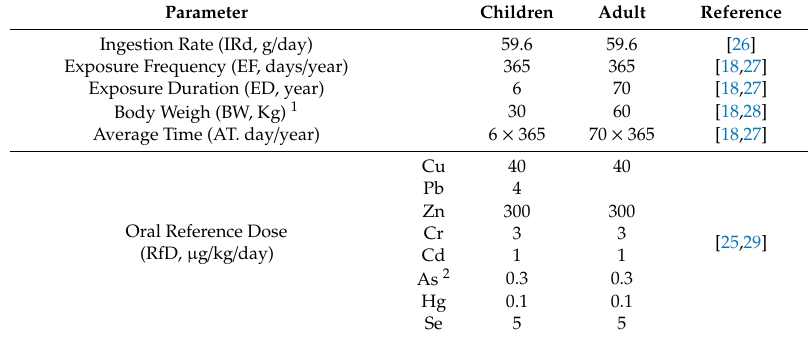
Table 2. Definition and reference values for some of the parameters used in the health risk assessment of